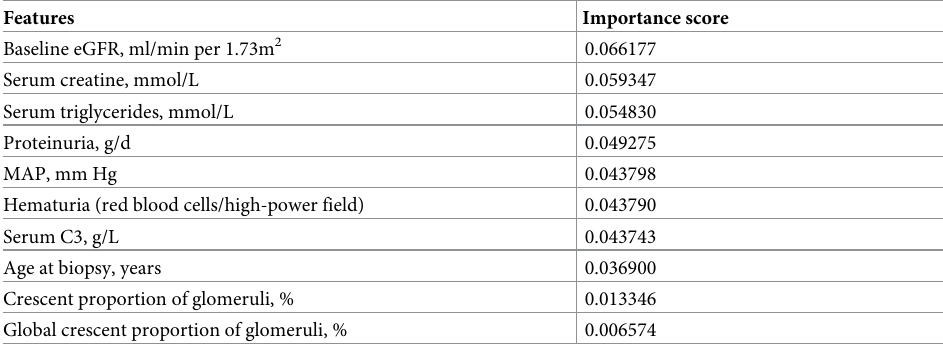
Table 2. Predictors selected using random forest and the corresponding feature importance score.